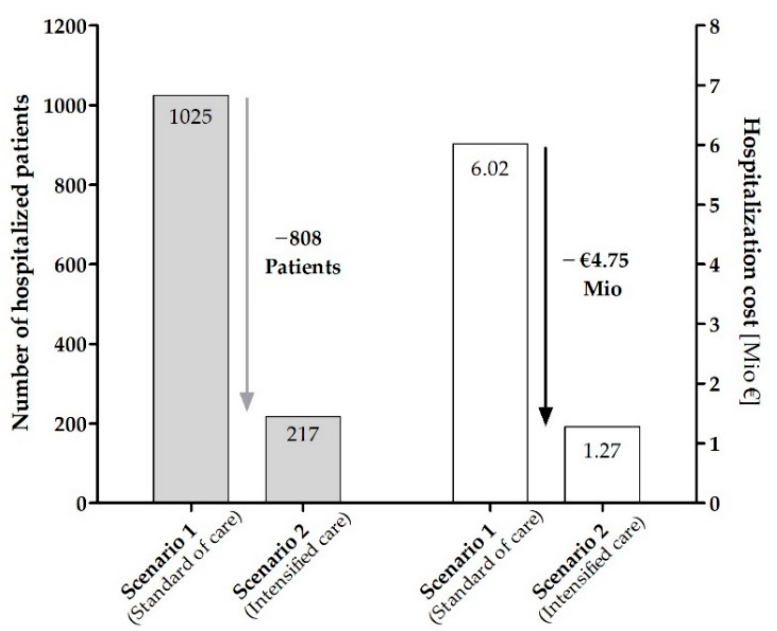
Figure 5. Estimated number of patients with OAT-related hospitalizations and potential savings based on the scenario analysis within the SHI collective of AOK Bayern. Abbreviations: Mio, million; OAT, oral anticancer treatment; SHI, statutory health